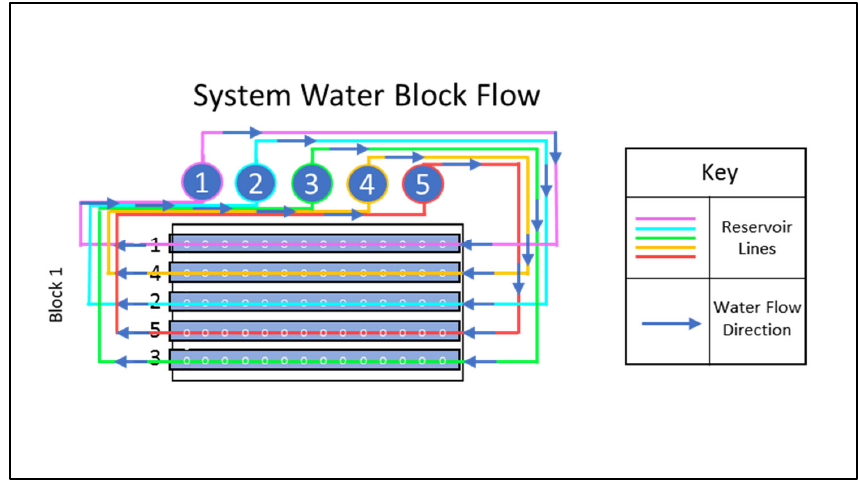
Figure 3. Aquaponic Example Block Water Flow.